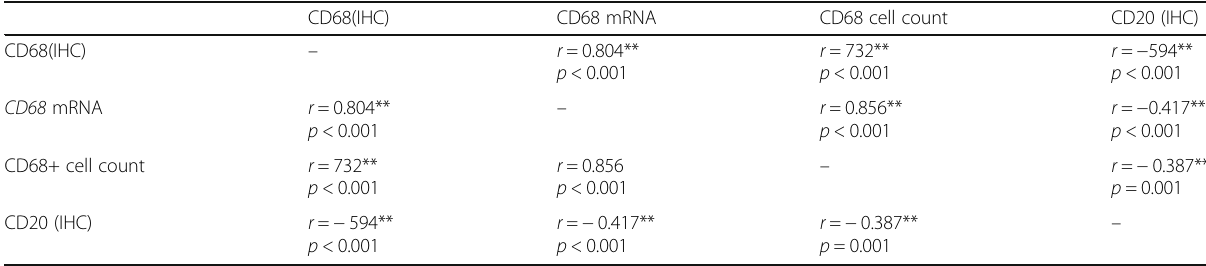
Table 6 Correlation of the CD68 cell count and expression of CD68 mRNA, CD68 protein and CD20 in patients with